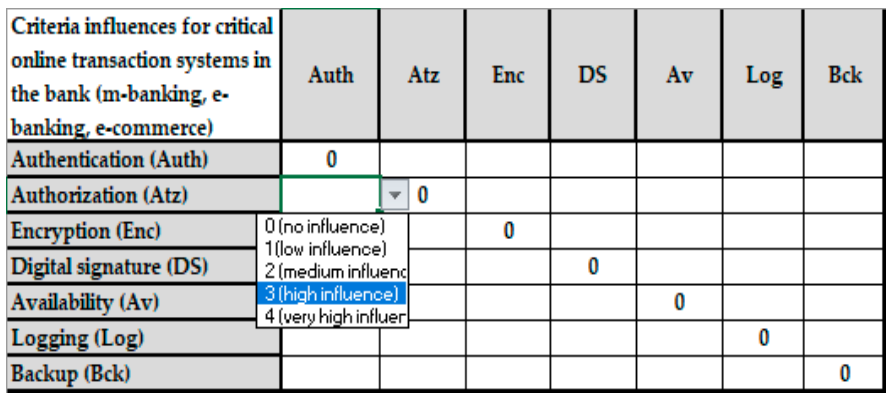
Figure 6. Matrix for estimating influences and dependencies between inherent critera for transaction systems. Table 5. Weights of inherent criteria for transaction systems obtained by SNAP12. Inherent Criteria for Transaction Systems (SNAP12)